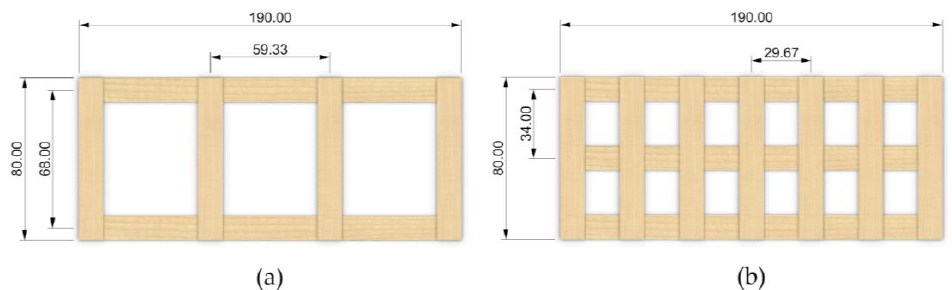
Figure 3. Veneer lattices produced: ( a ) Low-density lattice; ( b ) High-density lattice (dimensions in